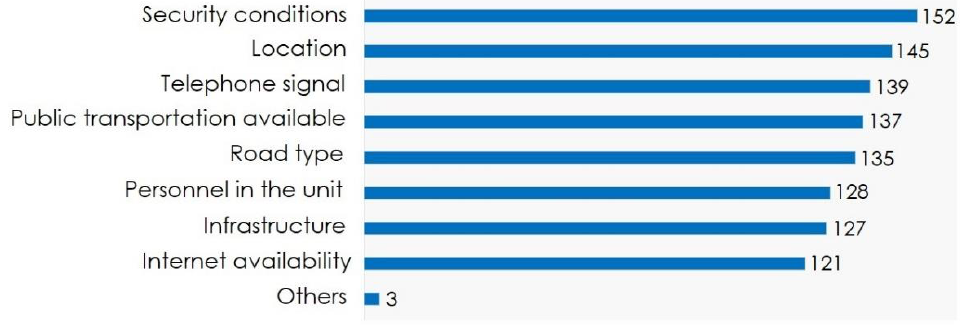
Figure 7. Information that SSMIS from the state of Zacatecas consider necessary to know before choosing a social service position ( n = 157), and the frequency of responses obtained by category.